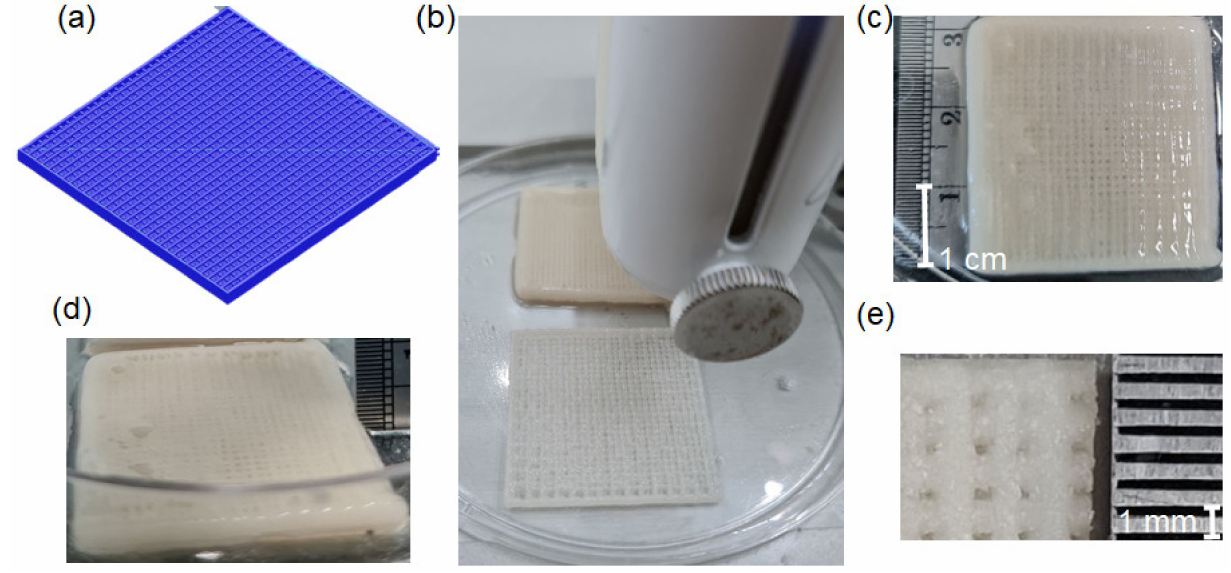
Figure 1. ( a ) Simulation from the G-code-designed 3D scaffold. ( b ) Pneumatic head for the extrusion of each filament. ( c ) Top view of the completed 3D-printed scaffold (30 × 30 × 2 mm). ( d ) Cross- sectional view of the scaffold. ( e ) Freeze-dried scaffold after cutting into 7 × 7 × 2 mm